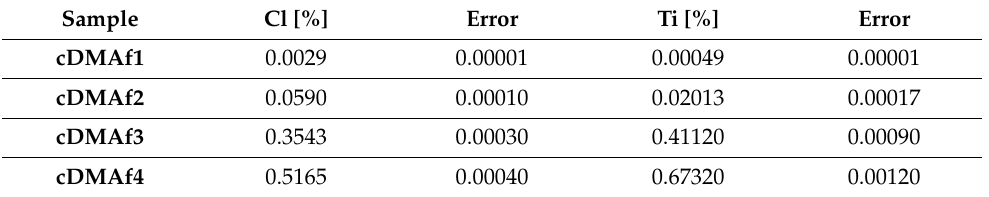
Table 2. Percentage of Ti and Cl incorporated into the copolymers determined by X-ray fluores- cence